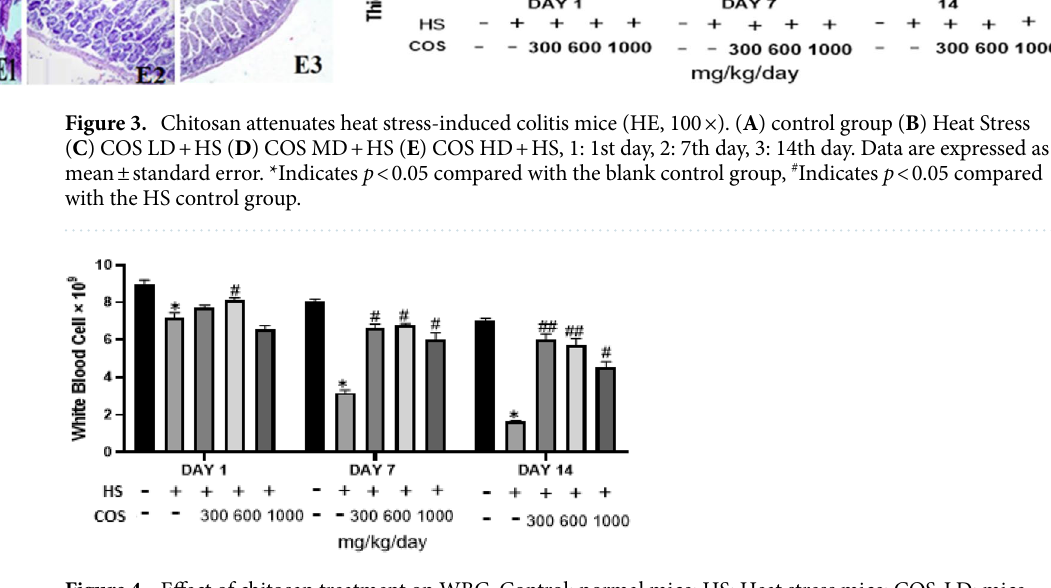
Figure 4. Effect of chitosan treatment on WBC. Control: normal mice; HS: Heat stress mice; COS-LD: mice treated with HS plus COS (300 mg/kg); COS-MD: mice treated with HS plus COS (600 mg/kg); COS-HD: mice treated with HS plus COS (1000 mg/kg). Data are expressed as mean ± standard error. *Indicates p < 0.05 compared with the blank control group, ## Indicates p < 0.01 and # Indicates p < 0.05 compared with the HS control